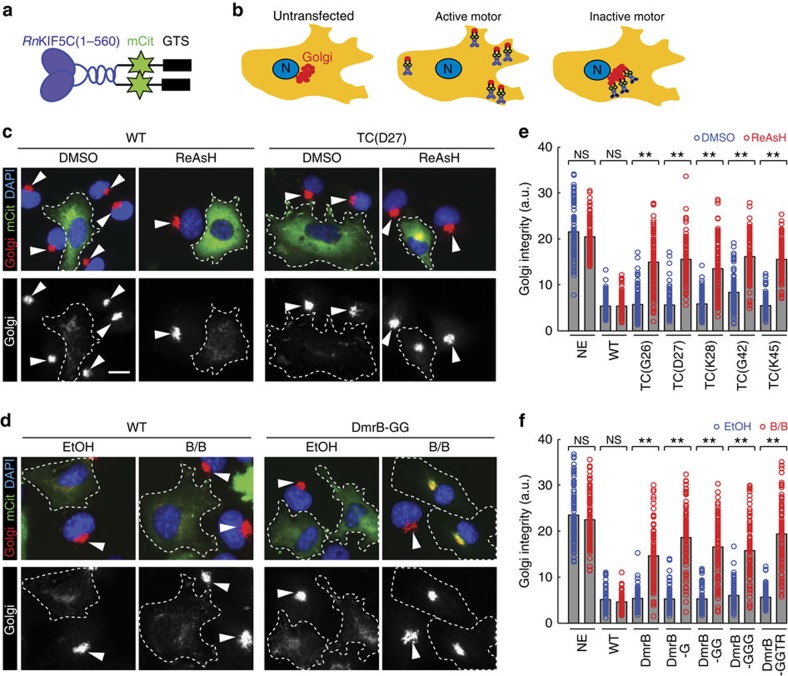
Inhibition of ectopic cargo transport by engineered kinesin-1 motors in cells.(a) Schematic of RnKIF5C(1-559) motor tagged with mCit and a Golgi targeting sequence (GTS). (b) Schematic of Golgi dispersion assay. In untransfected cells (left), the Golgi complex (red) is localized in a tightly packed, perinuclear cluster. Expression of active kinesin-GTS motors (middle) results in dispersion of the Golgi complex, whereas inhibition of these motors (right) retains the tightly-packed, perinuclear Golgi localization. N, nucleus. (c–f) COS7 cells expressing WT, TC-tagged or DmrB-tagged motors with a GTS were incubated in the absence (DMSO or EtOH) or presence of inhibitor (200–400 nM ReAsH or 1.5 μM B/B), fixed ∼14 h later, and then stained with 4', 6-diamidino-2-phenylindole (DAPI; blue) and an antibody to a Golgi marker (Giantin; red). (c,d) Representative images of cells expressing (c) WT or TC(D27) constructs, or (d) WT or DmrB-GG constructs. The top panels show merged images, whereas the bottom panels show only the Golgi fluorescence signal. White dotted line, outline of cells expressing engineered motors. Arrowheads indicate compact Golgi complex in non-expressing (NE) cells. Scale bar, 15 μm. (e,f) Quantification of Golgi dispersion. The data are presented as the Golgi integrity where low values reflect a dispersed Golgi complex (motors active) and high values reflect a compact perinuclear Golgi complex (motors inhibited). Each circle represents the Golgi integrity of an individual cell in the presence (red) or absence (blue) of the respective inhibitor. Grey bars represent means of (e) n≥100 or (f) n≥76 cells over three independent experiments. P-values were calculated with a heteroscedastic, two-tailed t-test; NS, not significant (P>0.05); **P<0.000001.